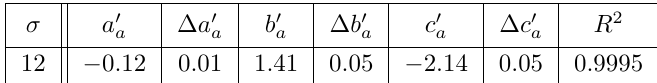
Table 11 . Parameter of the fit (4.4) for resonance parameter σ = 12 and maximum temperature exponent α = 7 . 5 . ∆ a 0 is the uncertainty of the parameter a 0 m b the fit.